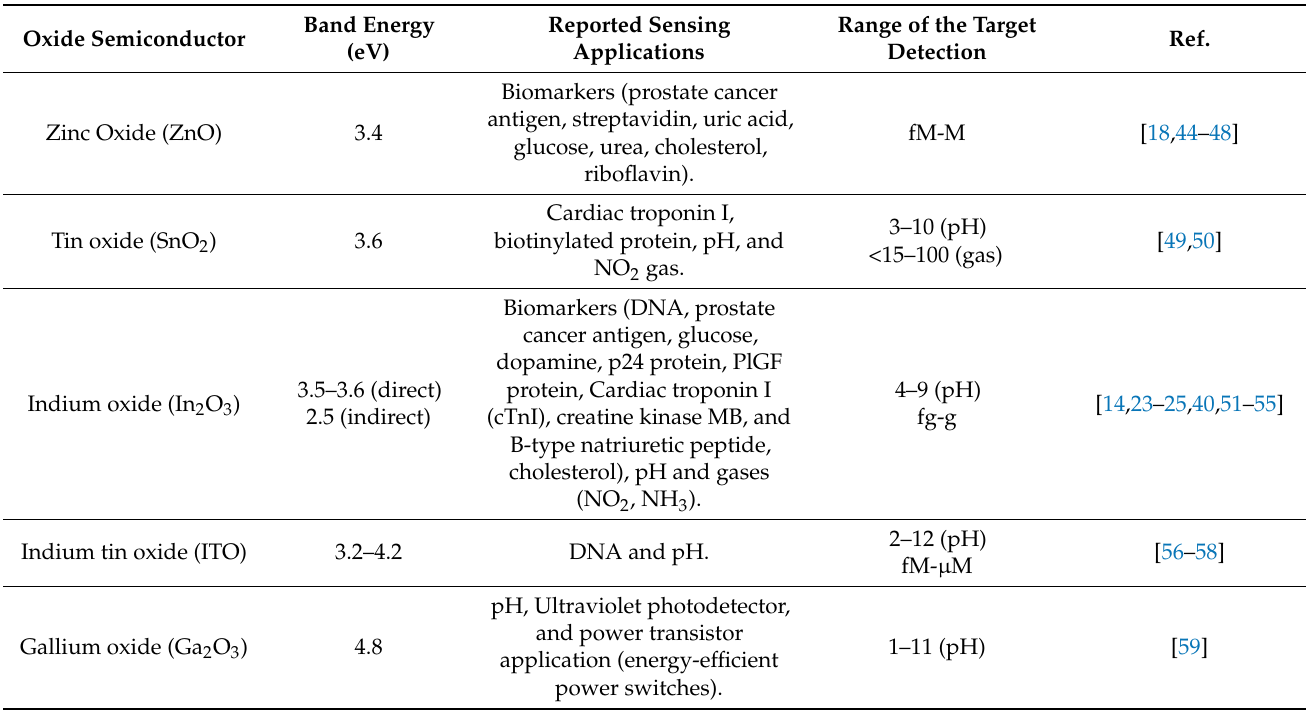
Table 1. Commonly used metal-oxide semiconductor materials-based FET for bio/chemical sensing applications. Reported Sensing Range of the Target Applications Detection